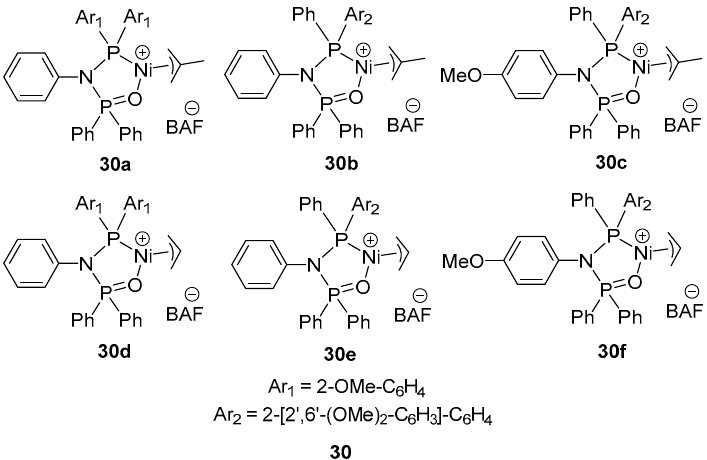
Figure 27. 2-Methylallyl- and allyl-based nickel catalysts bearing PNPO ligands 30a – f .